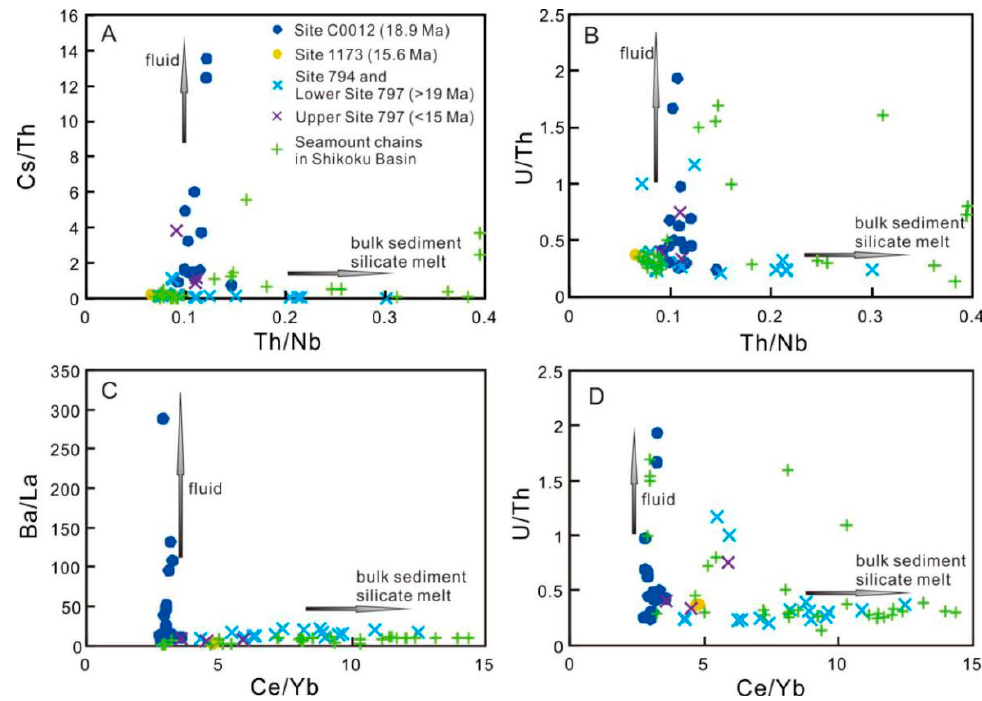
Figure 16. The plots of Cs/Th versus Th/Nb ( A ), U/Th versus Th/Nb ( B ), Ba/La versus Ce/Yb ( C ), U/Th versus Ce/Yb ( D ) for Site C0012, 1173 volcanic rocks from the Shikoku Basin. Data sources as for Figure 6.